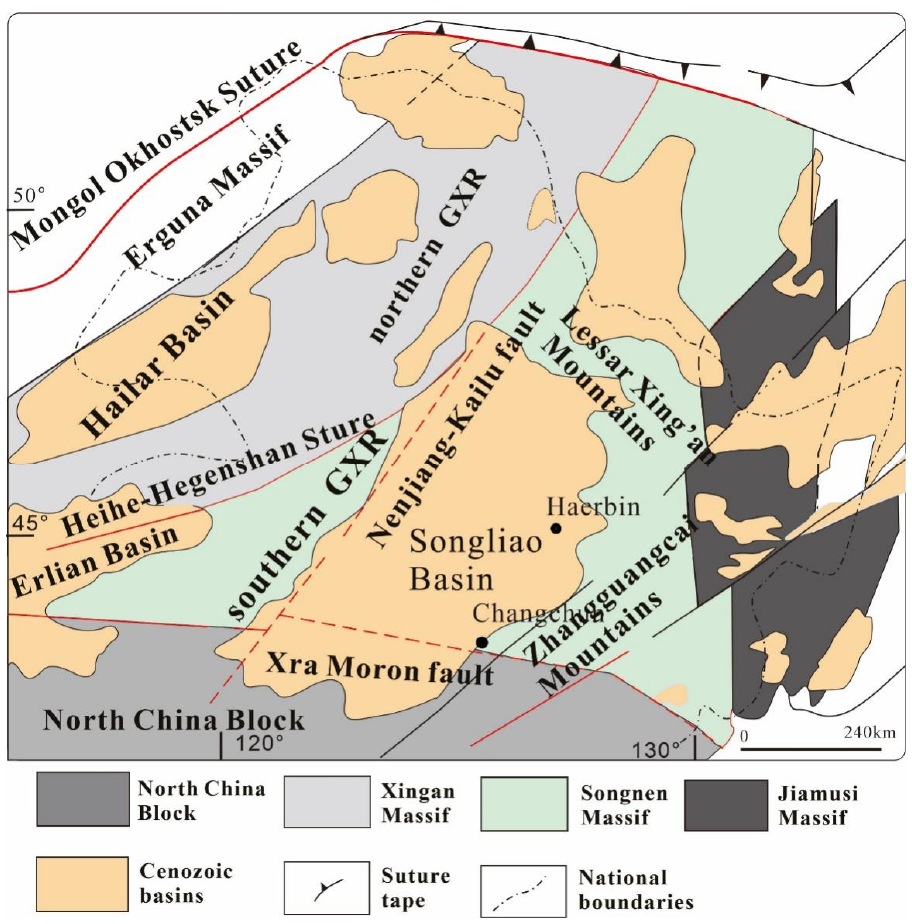
Figure 1. Sketch geological map of northeastern China (after [29,30]). GXR, Great Xing’an